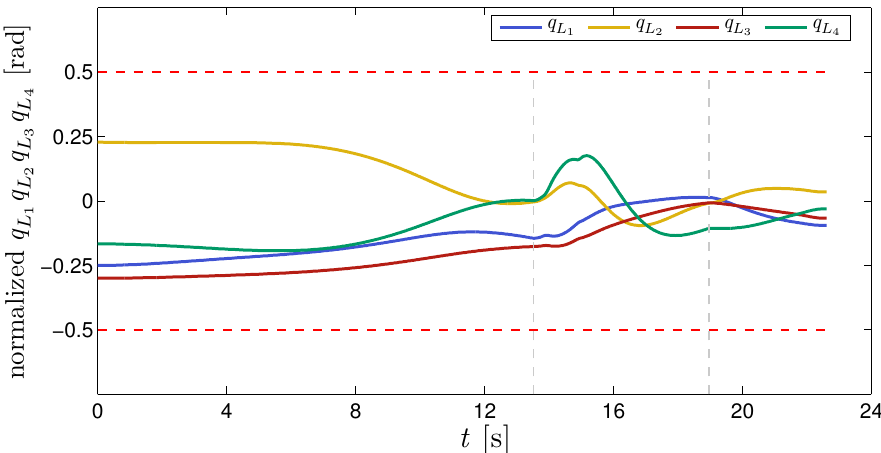
Figure 13. Changes of configuration variables for the left arm.